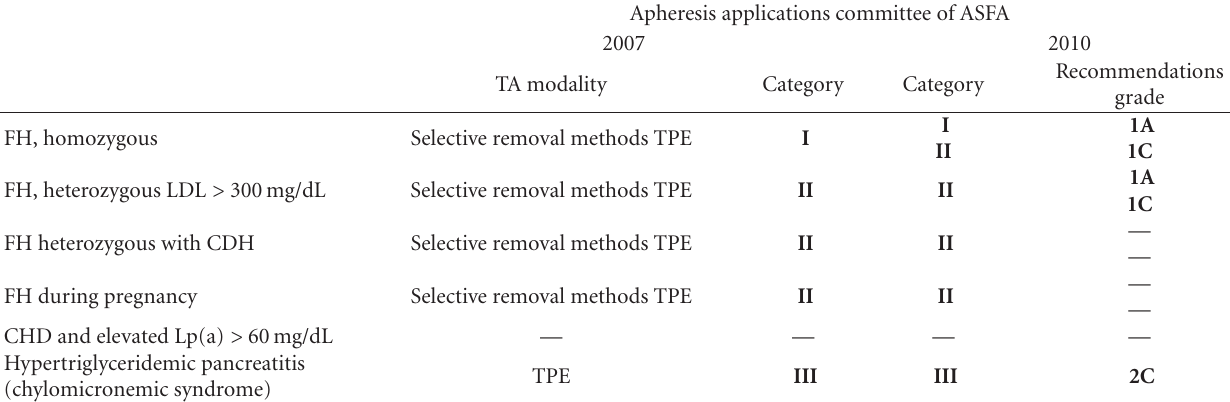
Table 7: Guidelines on the use of TA in hyperlipidemia [40,